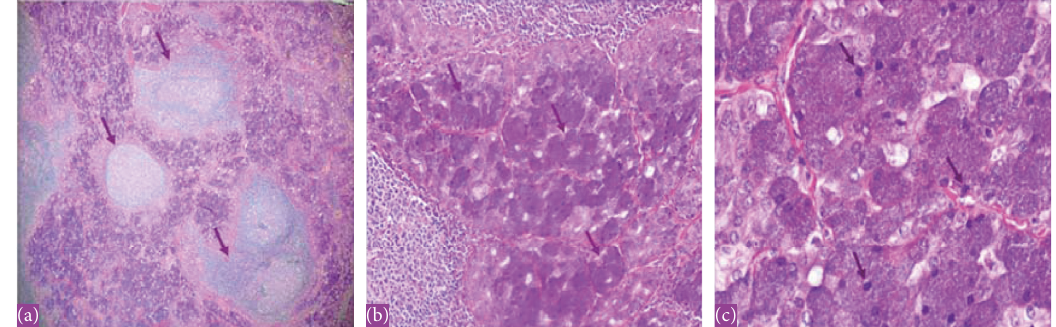
Figure 2: The histopathology with hematoxylin and eosin (H&E) stain showing a multifocal acinic cell carcinoma of the right parotid gland in 2017. (a) Low power showing lymphoid-rich stroma with lymphoid follicles and prominent germinal centers within tumor. (b) Medium power showing tumor with acini and granular cytoplasm. (c) High power x60 showing the basophilic granular cytoplasm (zymogen granules of neoplastic serous